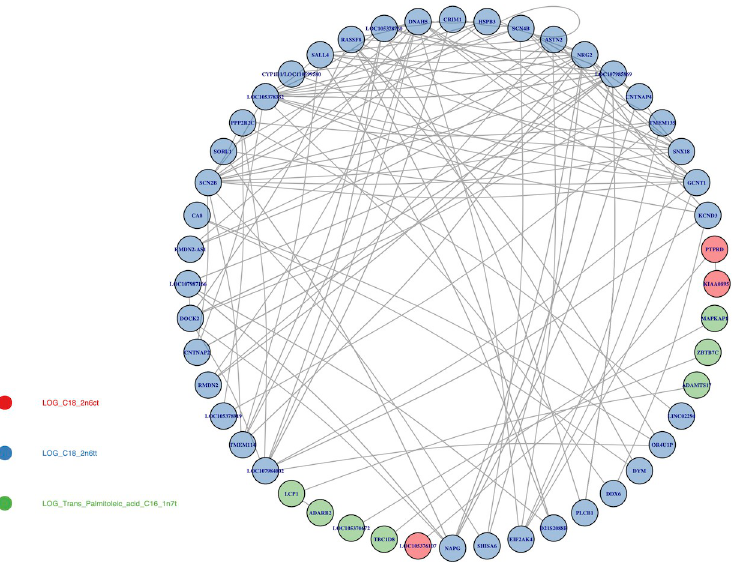
Fig 11. Mapping significant interactions at the gene level with FDR less than 0.05. The significant interactions with FDR less than 0.05 with appropriate gene annotations were selected. Two omega-6 fatty acids (C18:2n6ct in red and C18:2n6ct in blue) and the trans-palmitoleic acid (C16:1n7t in green) had significant interactions that mapped to genes. Multiple genes, including DNAH5 and NRG2 , were involved in more than one interaction.